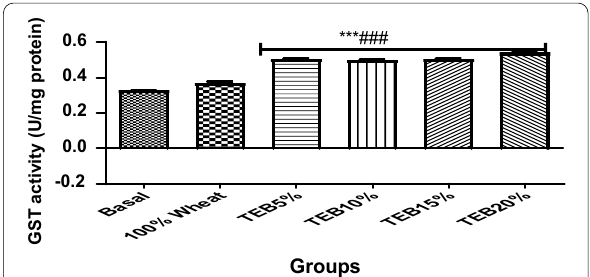
Fig. 14 Effect of enzymatic tacca–wheat biscuit on albino Wistar rats by glutathione S-transferase (GST) activities. 100% Wheat: Rats fed with 100% wheat flour biscuit, TEB5%: Rats fed with 5% enzymatic tacca flour 95% wheat flour biscuit, TEB10%: Rats fed with 10% + 95% wheat enzymatic tacca flour 90% wheat flour biscuit, TEB15%: Rats fed + + 90% with 15% enzymatic tacca flour 85% wheat flour biscuit, TEB20%: + + Rats fed with 20% enzymatic tacca flour 80% wheat flour biscuit +